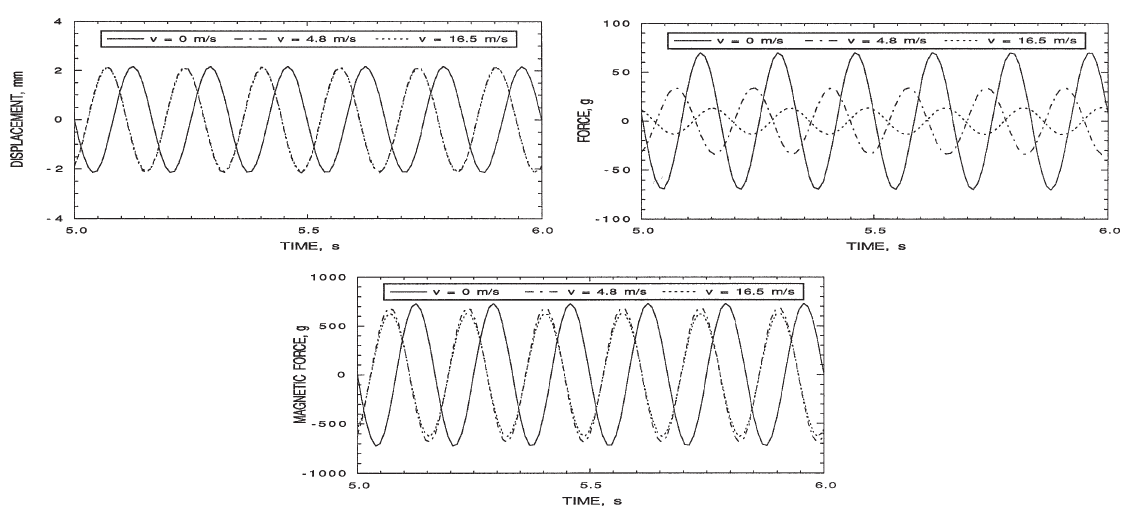
Fig. 3. Displacement, total force, and magnetic force as a function of time at an excitation of 6 Hz, test